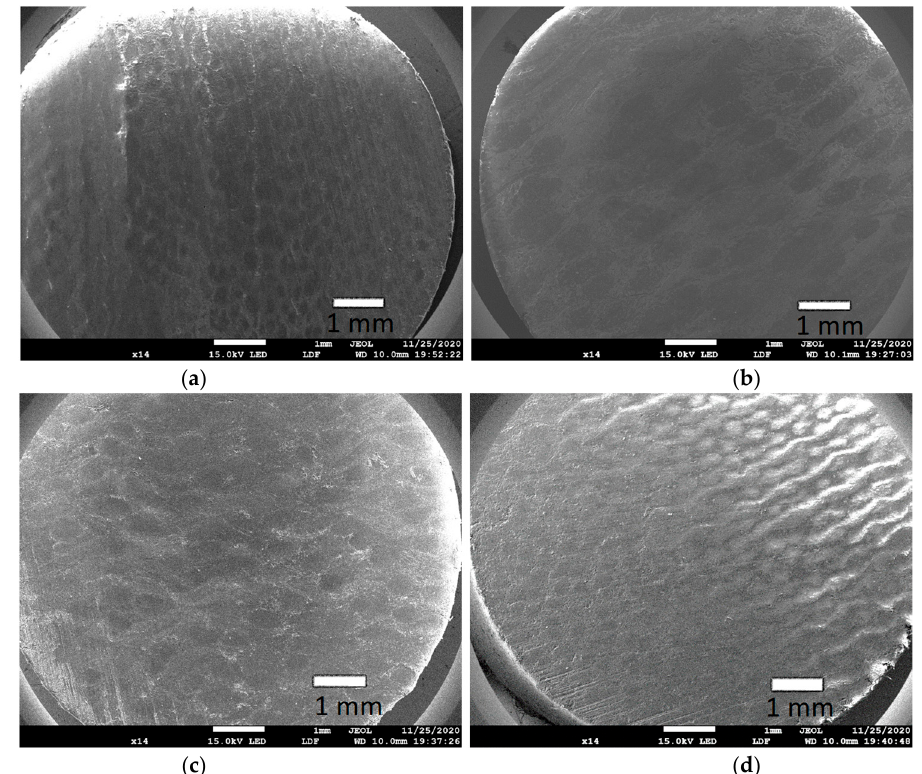
Figure 16. SEM micrographs of pins: ( a ) PF + cotton ( b ) PF + jute ( c ) PF + cotton + MoS 2 , and ( d ) PF + cotton + C.